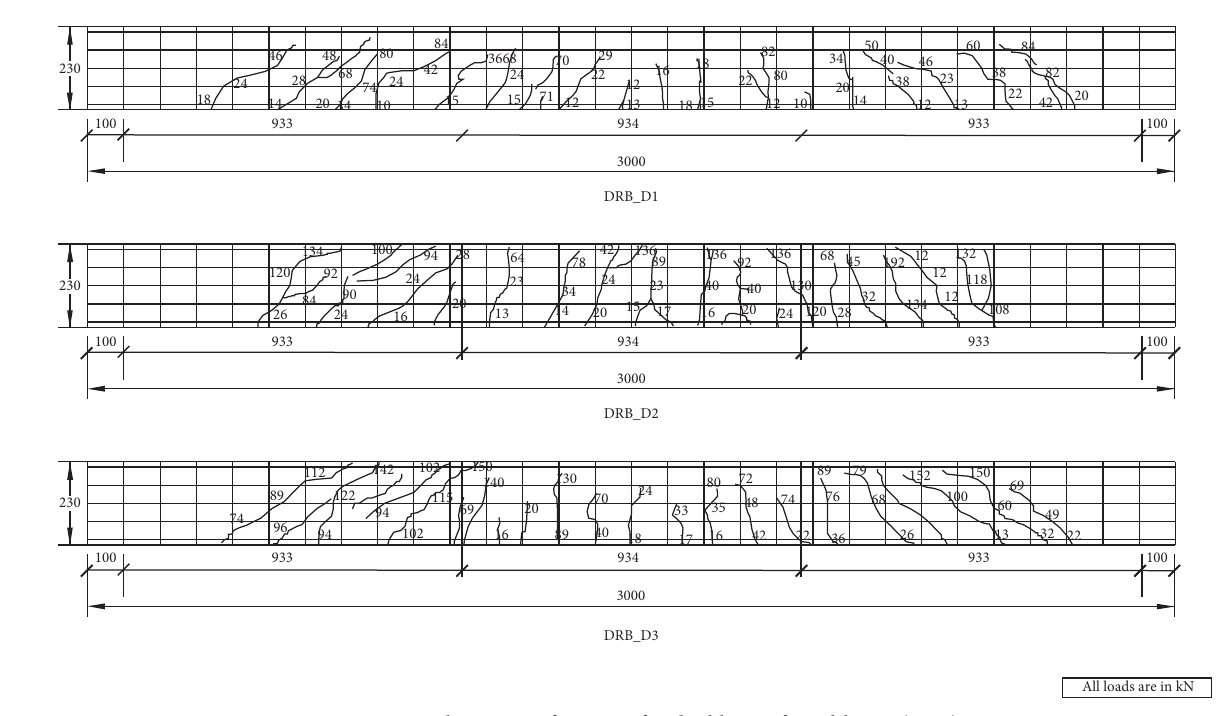
Figure 9: Crack pattern of GPCSC for doubly reinforced beam (DRB).